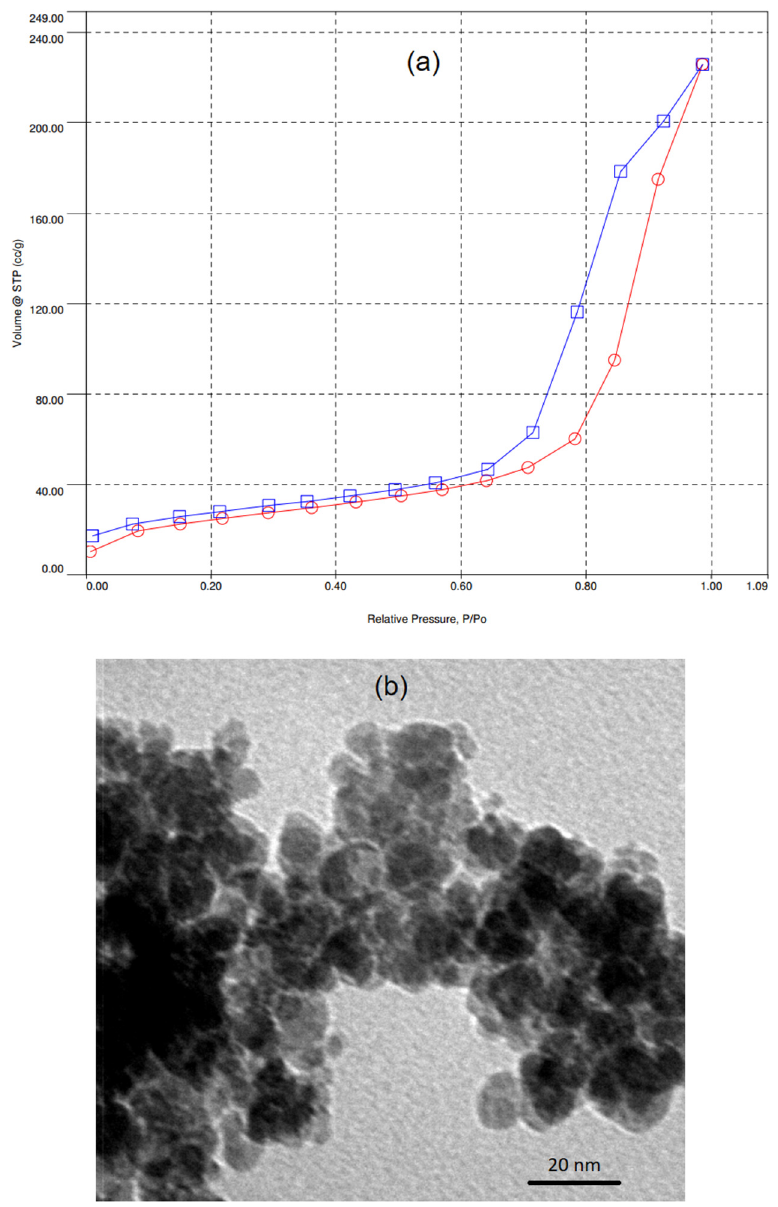
Figure 3. ( a ) N 2 adsorption / desorption isotherm and ( b ) TEM image of synthetic bioactive Table 2. Nitrogen adsorption/desorption characterization of bioactive glass 70SiO 2 ‐ 30CaO. Samples